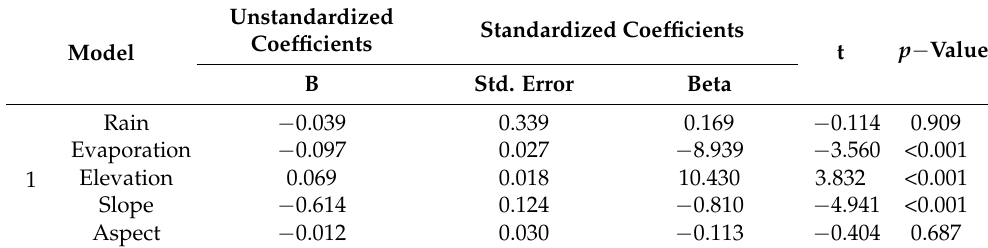
Table 2. First run of BMLR.